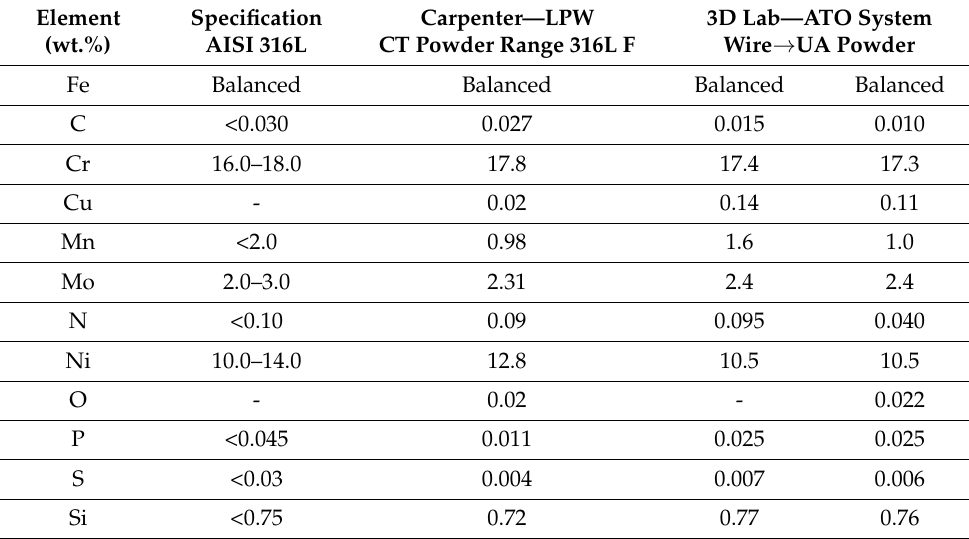
Table 4. Chemical composition of PAGA and UA